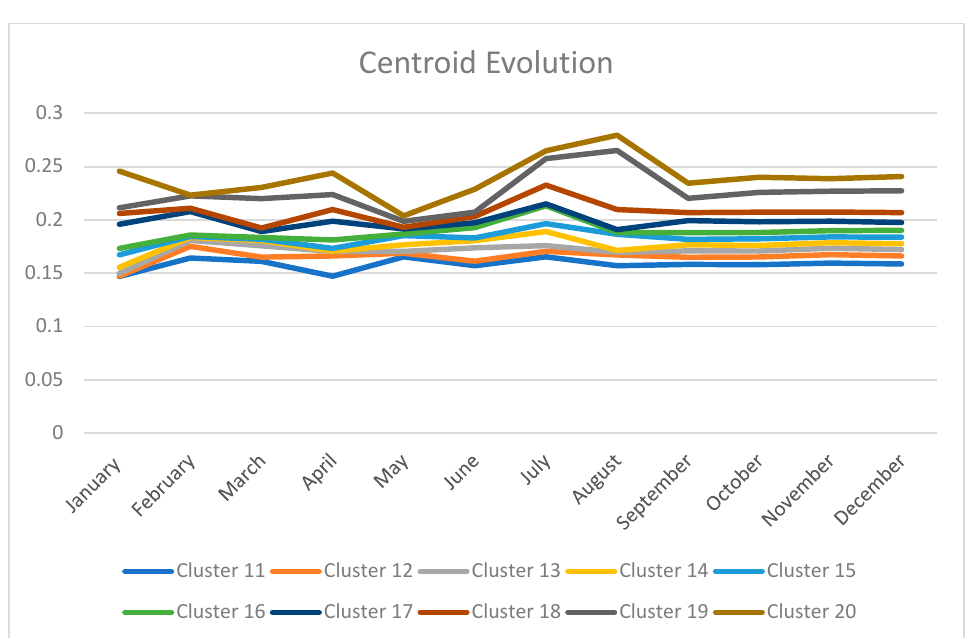
Figure 2. Evolution of the centroids of the last 10 with X-means.